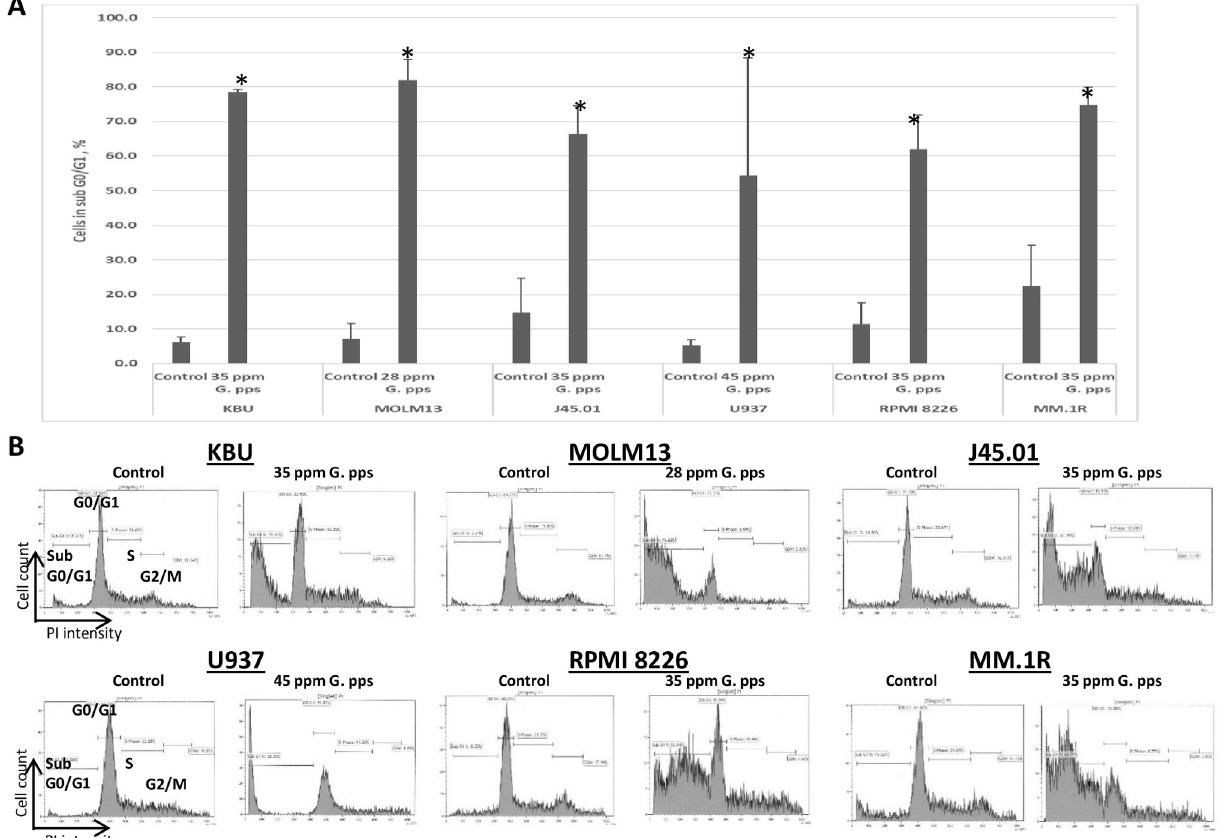
Fig 3. Extract from Gymnopilus purpureosquamulosus ( G . pps ) increases cells in sub G0/G1 phase. (A) Cells were exposed to DMSO (Control) or the indicated concentrations of G . pps extract for 48 h, fixed, washed, stained with propidium iodide and analyzed by flow cytometry. The results are average ( ± standard deviation) of three independent experiments. (B) Representative plots for cell cycle analysis by flow cytometry are shown (10,000 events). Asterisk ( � ) denotes P < 0.01 compared with control.